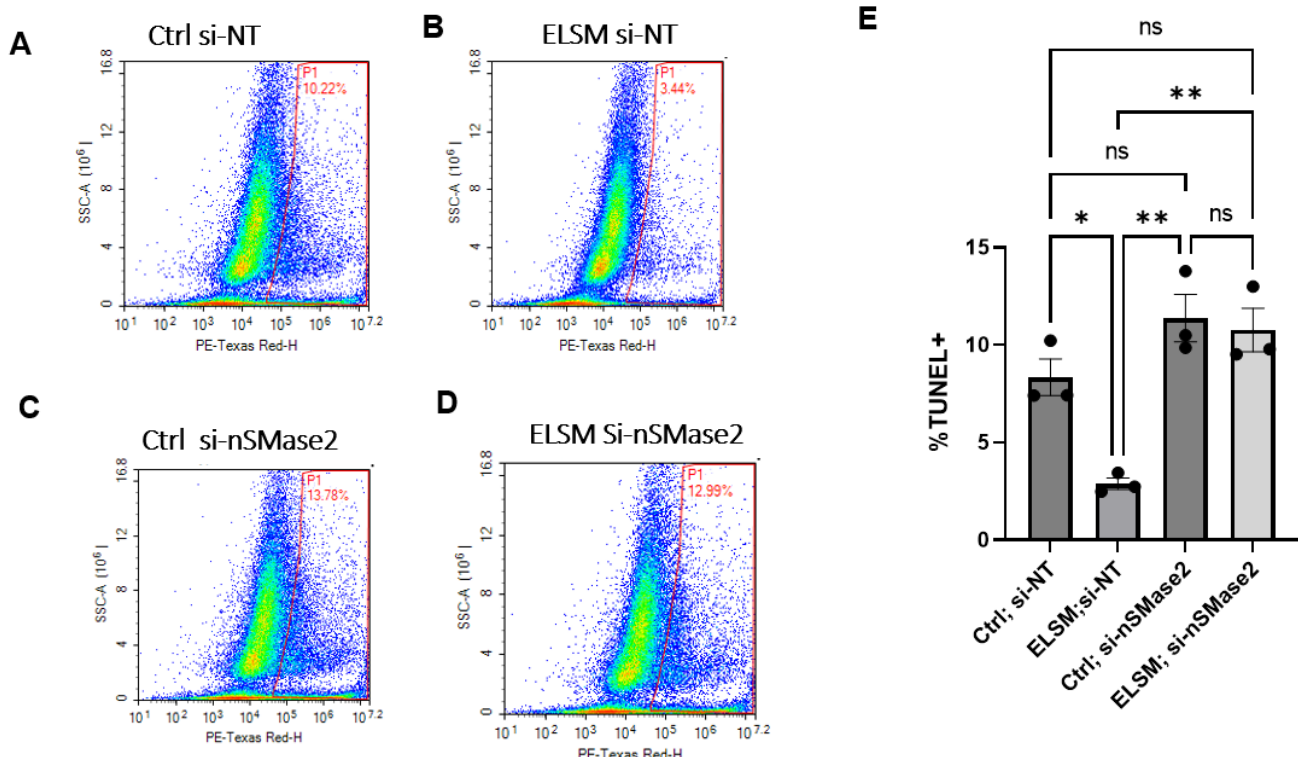
Figure 5. Reduced apoptosis in HL-1 cardiomyocytes treated with CM from ELSM-treated C-MSC is dependent on nSMase2. ( A – D ) Percentage of TUNEL+ cardiomyocytes treated with CM from si-NT transfected C-MSC without ELSM, si-NT transfected C-MSC with ELSM, si-nSMase2 transfected C-MSC without ELSM, and si-nSMase2 transfected C-MSC with ELSM; ( E ) statistical analysis of the percentage of TUNEL+ cardiomyocytes in the 4 groups (ns not significant; * p < 0.05, ** p < 0.01, n = 3).